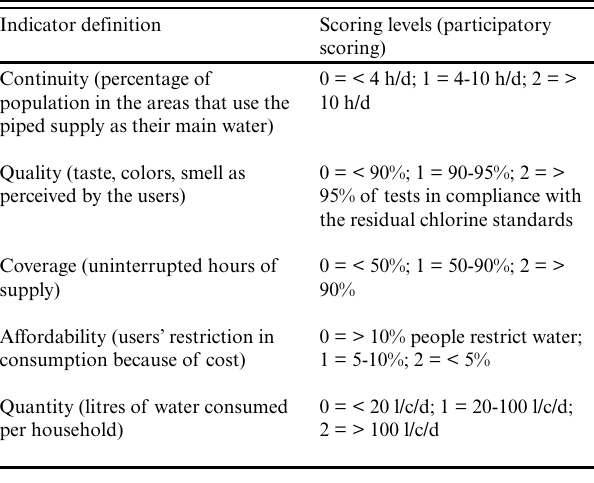
Table 3 . Water service delivery approach (WSDA) performance indicators and their